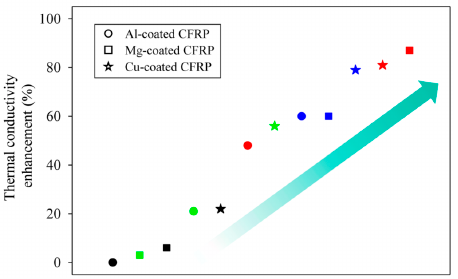
Figure 5. Through-thickness thermal conductivity enhancement of CFRP composites coated with three types of inorganic crystal fillers. The four colors refer to different weight fractions of fillers—red: 0.01 wt %; blue: 0.1 wt %; green: 0.2 wt %, black: 0.4 wt %.